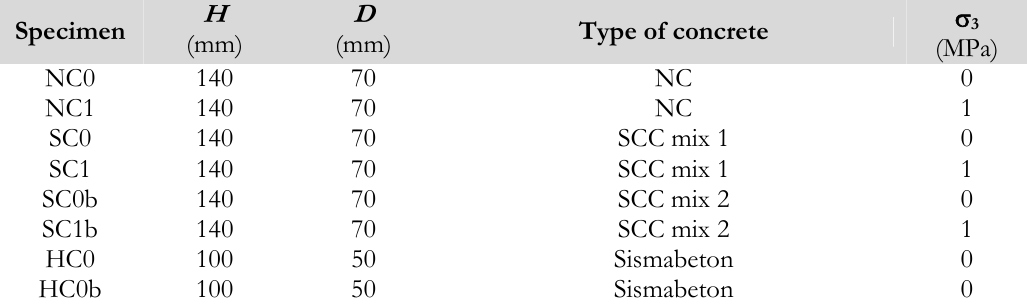
Table 2: Mechanical and geometrical properties of the specimens tested in uniaxial and triaxial compression.